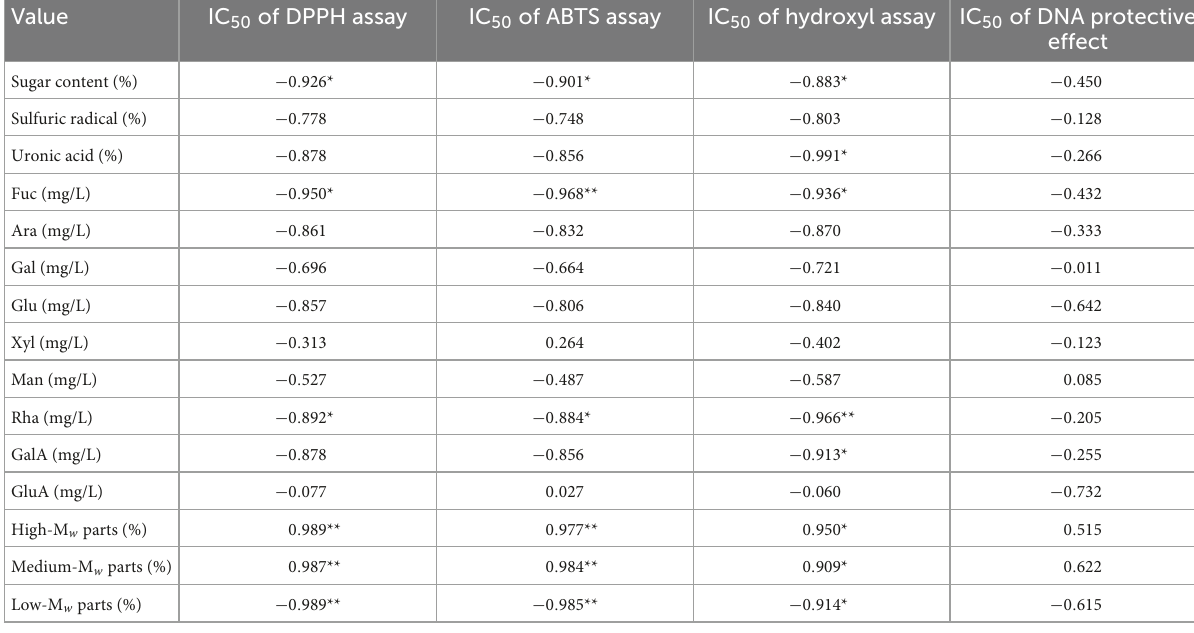
TABLE 4 Matrix for correlation